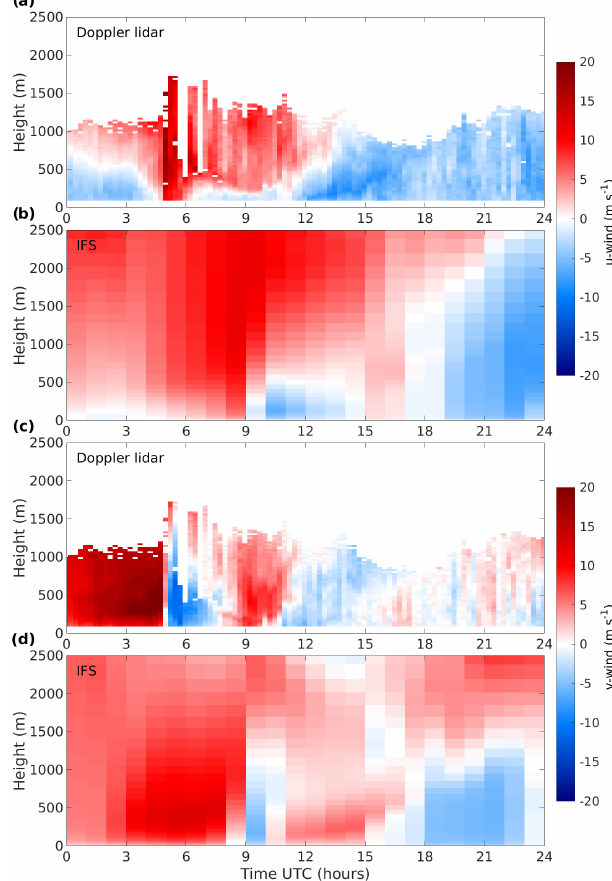
Figure 12. (a) Doppler lidar u wind, (b) IFS u wind, (c) Doppler lidar v wind, and (d) IFS v wind at SGP on 7 August